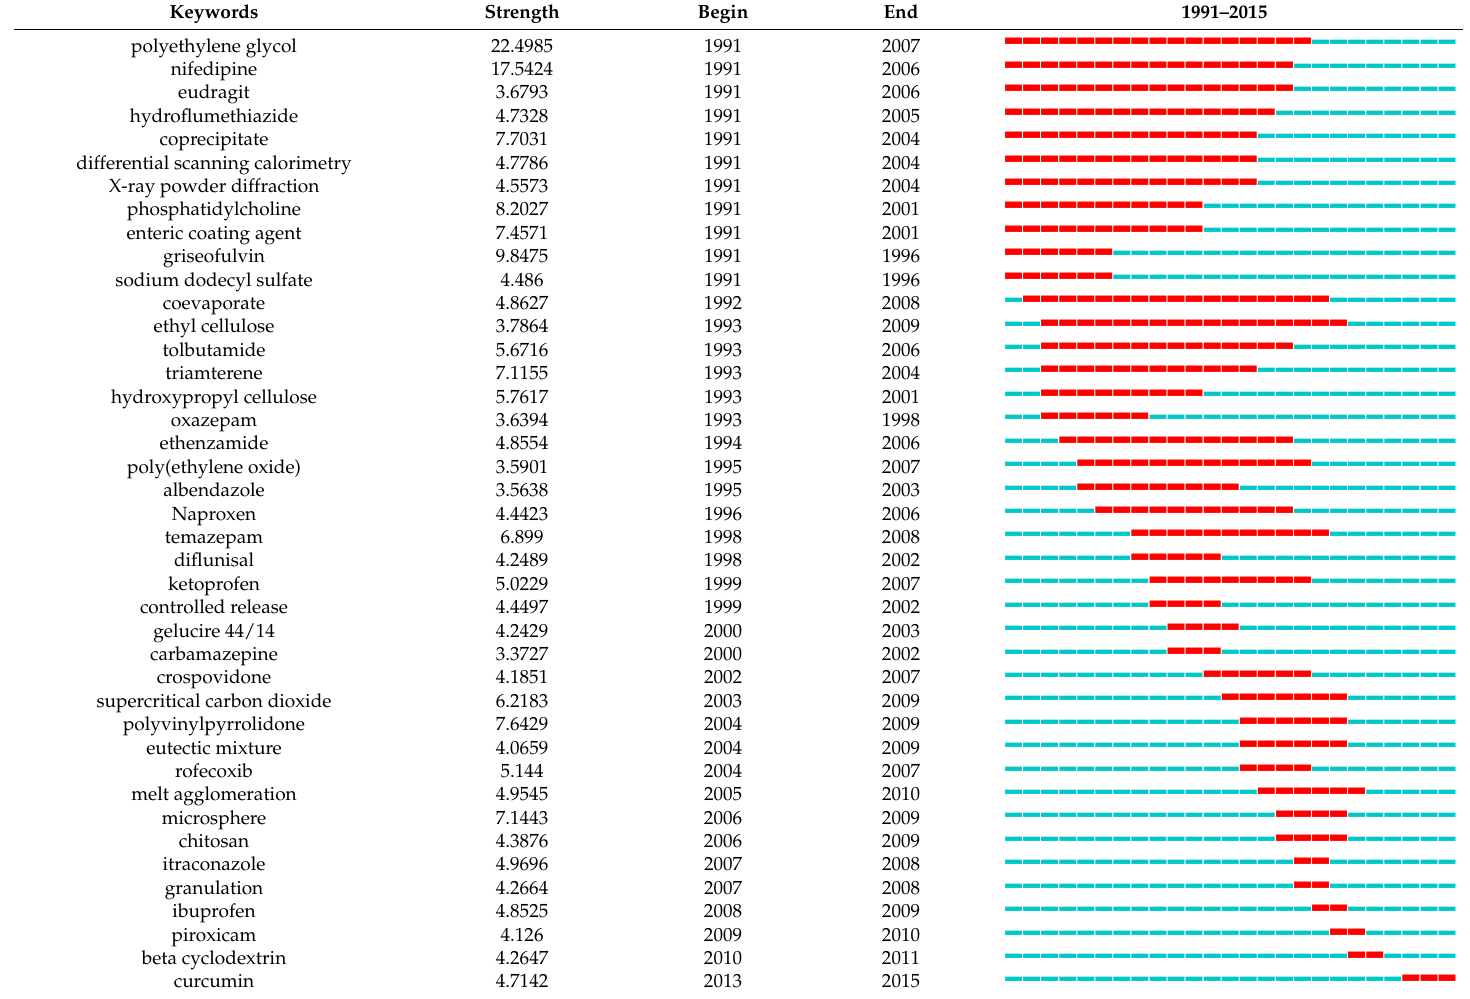
Table 6. Terms of active research clusters with time from co-citation